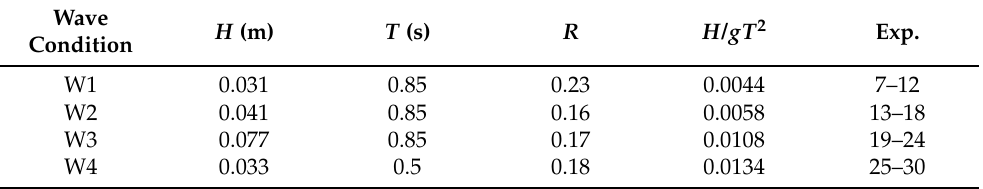
Figure 1. Schematic view of the experimental setup. Table 1. Measured wave conditions. The reflection coefficient R was evaluated following [32]. The last column refers to the experiment number. Table